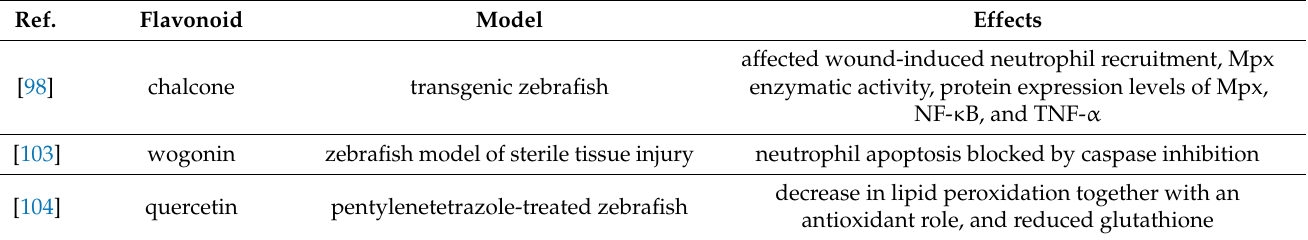
Table 4. Studies employing zebrafish to assess the anti-inflammatory activity of flavonoids.